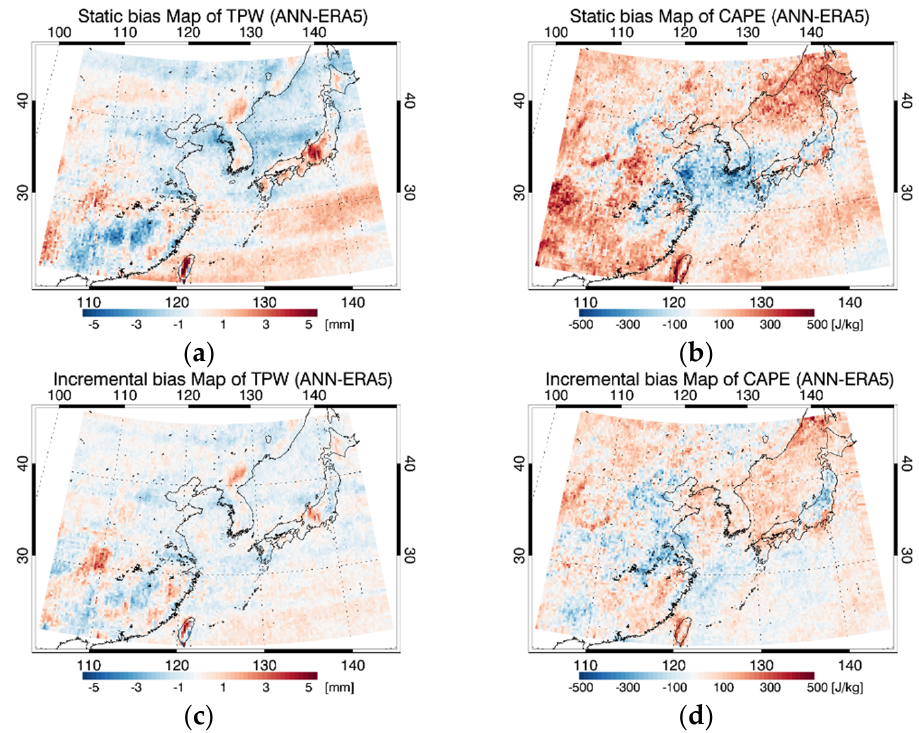
Figure 11. Spatial error map, in terms of bias, from the testing results depending on the learning method for TPW and CAPE in ELA region for the test period (24 July 2020 to 24 July 2021). The upper figures represent bias maps between ERA5 and ST ANN model ( a , b ) and the lower figures represent bias maps between ERA5 and INC ANN model ( c , d ).